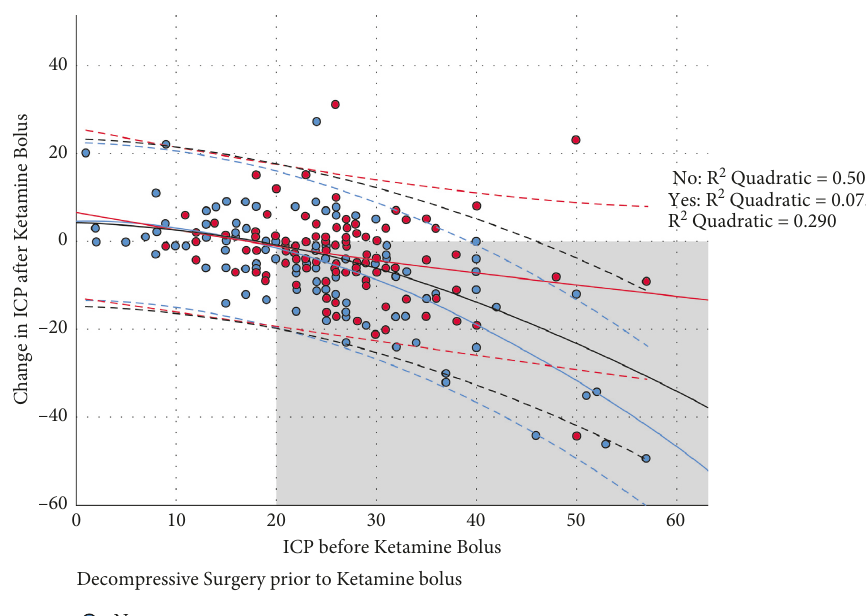
Figure 1: Change in ICP after ketamine bolus according to baseline ICP values. The blue circles represent patients without decompressive surgery, whereas the red circles are those with decompressive surgery. The bold lines are the regression lines (black for the whole population and red and blue for those with and without decompressive surgery, respectively), whereas the dashed lines are the 95% confidence intervals around the regression lines. The gray zone represents events where the ICP decreased the greatest according to the regression model.